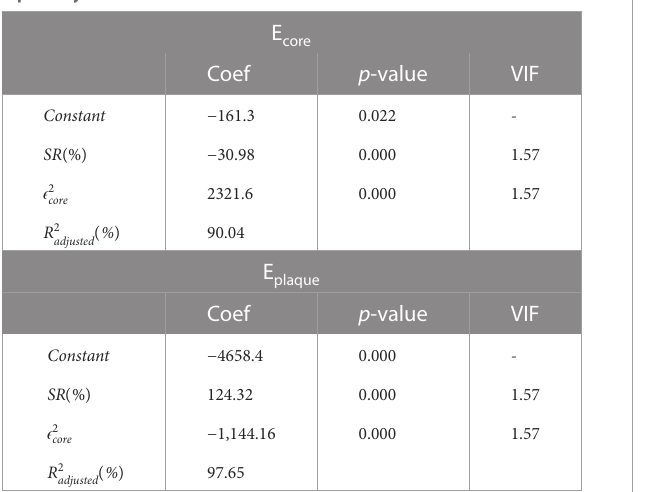
FIGURE 6 Relative error in the prediction of E core (blue) and E plaque (green) in the training and testing steps of the ANN.